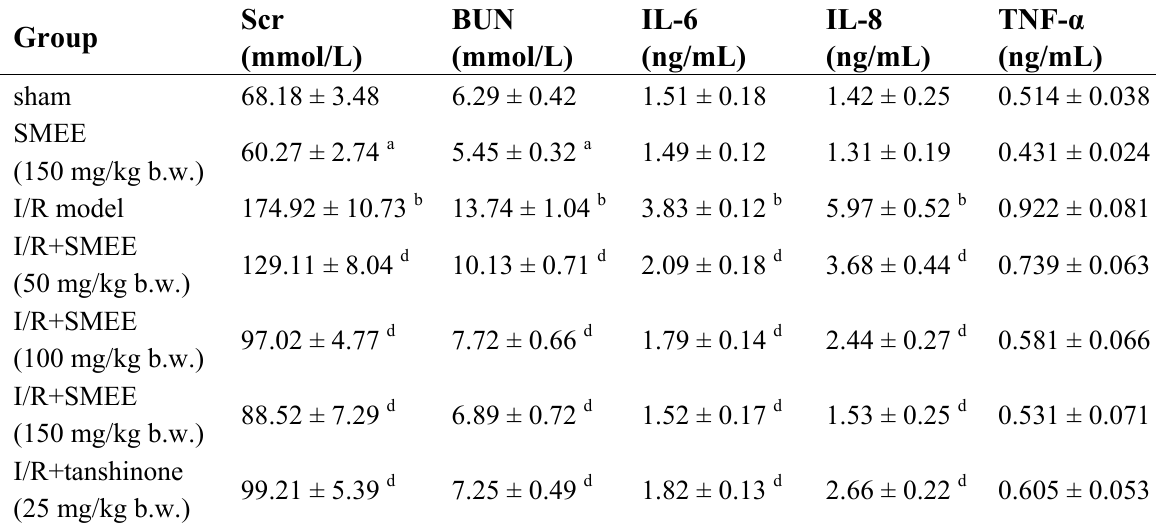
Table 1. Effect of Salvia miltiorrhiza ethanol extract pretreatment on serum Scr, BUN, renal IL-6, IL-8 and TNF- α levels in experimental rats. Scr BUN IL-6 IL-8 TNF- α Group (mmol/L) (mmol/L) (ng/mL) (ng/mL) (ng/mL) sham 68.18 ± 3.48 6.29 ± 0.42 1.51 ± 0.18 1.42 ± 0.25 0.514 ± 0.038 SMEE 60.27 ± 2.74 a 5.45 ± 0.32 a 1.49 ± 0.12 0.431 ± 0.024 a (150 mg/kg b.w.) I/R model 174.92 ± 10.73 b I/R+SMEE 129.11 ± 8.04 d I/R+SMEE 97.02 ± 4.77 d 7.72 ± 0.66 d (100 mg/kg b.w.) I/R+SMEE 88.52 ± 7.29 d 6.89 ± 0.72 d (150 mg/kg b.w.) I/R+tanshinone 99.21 ± 5.39 d 0.605 ± 0.053 (25 mg/kg b.w.)